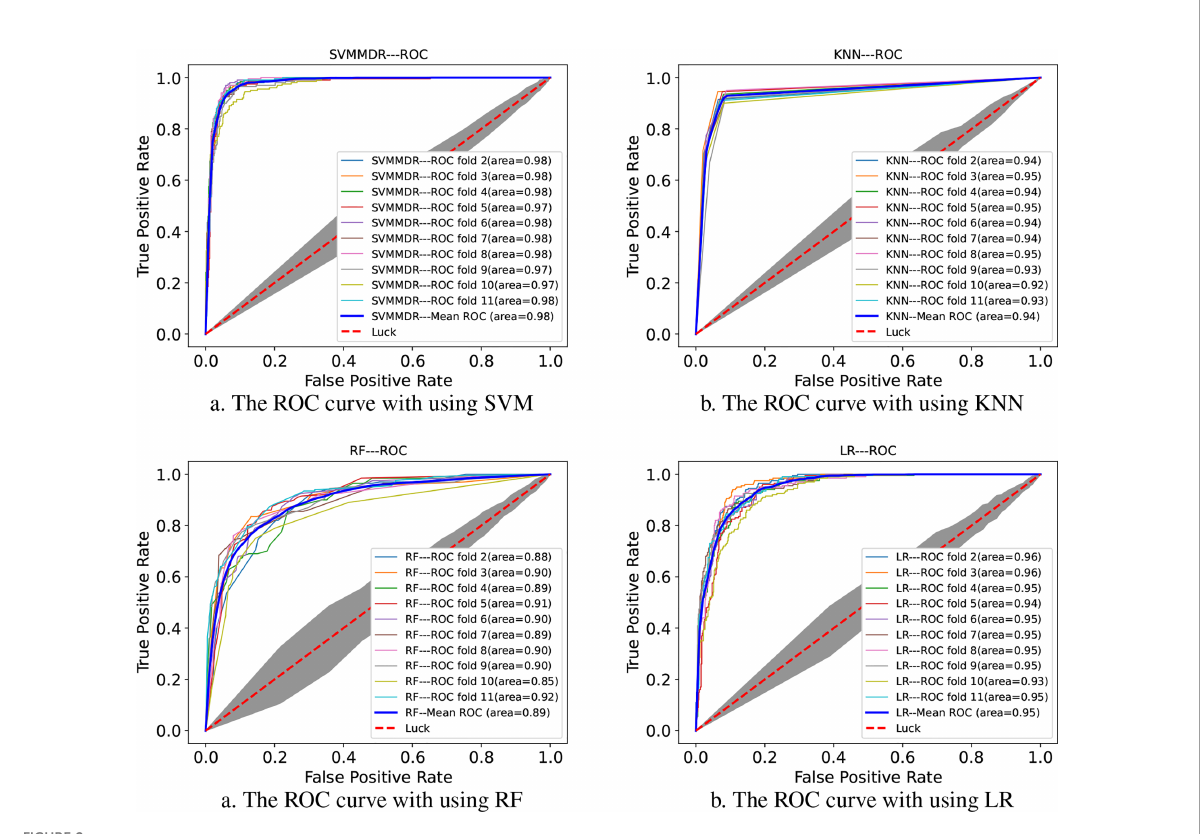
FIGURE 2 The ROC curve comparison with existing machine learning